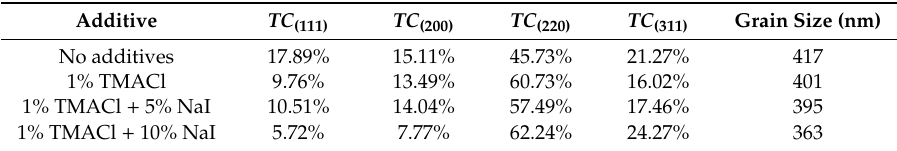
Figure 8. The XRD patterns of the electrodeposition Al coating obtained on a copper foil in AlCl 3 -NaCl-KCl (80–10–10 wt.%) molten salts electrolyte, without additive, 1% TMACl, 1% TMACl + 5% NaI and 1% TMACl + 10% NaI, at 150 °C. Table 1. The TC values and grain sizes calculated from XRD reflections, Al coating electrodeposited without additive, with 1% TMACl, and with 1% TMACl + 10% NaI.